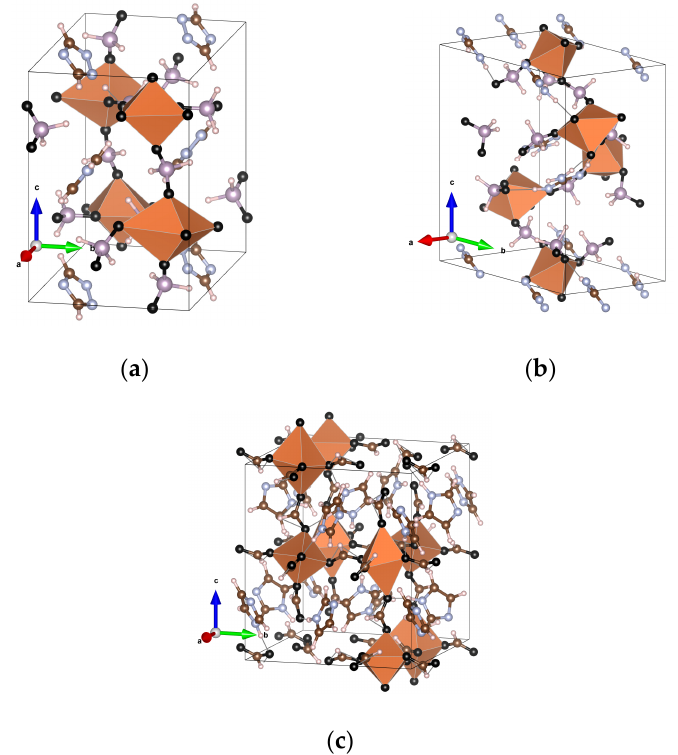
Figure 1. Unit cells of the considered materials. ( a ) [Trz]Cu(H 2 POO) 3 , with space group P2 1 /c. ( b ) [Gua]Cu(H 2 POO) 3 , with space group P 1. ( c ) [HIm]Cu(HCO 2 ) 3 , with space group P2 1 / c. Color code: The orange octahedra are Cu centered, with oxygen (black) at the vertices; P—gray; C—brown; H— white; N—blue.